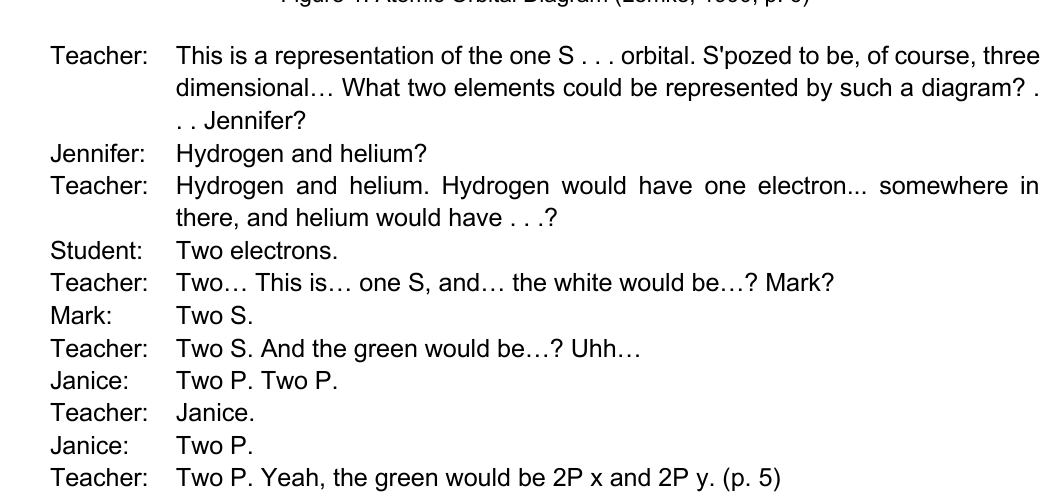
Figure 1: Atomic Orbital Diagram (Lemke, 1990, p.